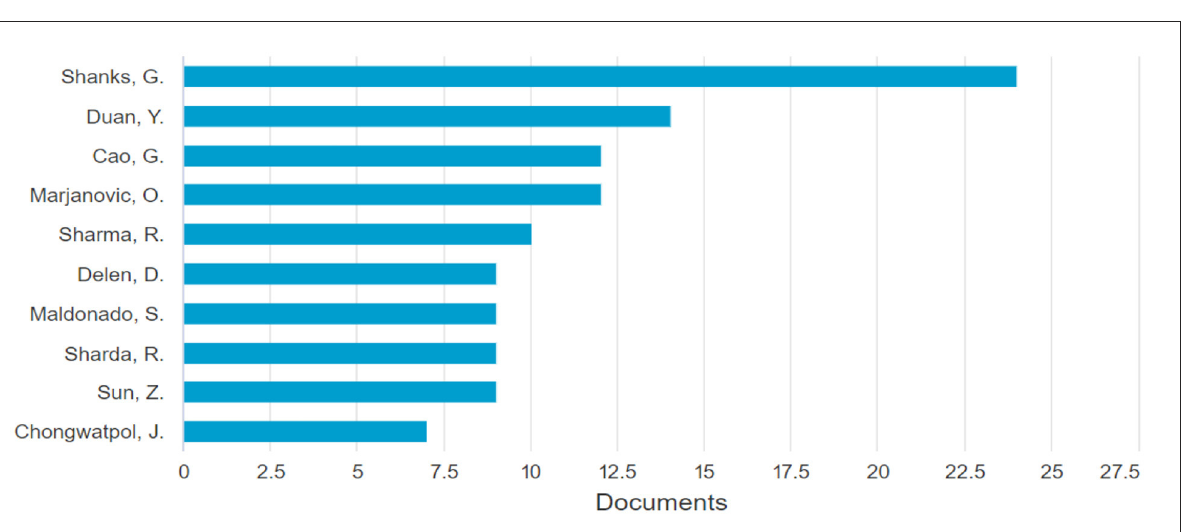
FIGURE4 Most relevant authors. Source: Own elaboration using